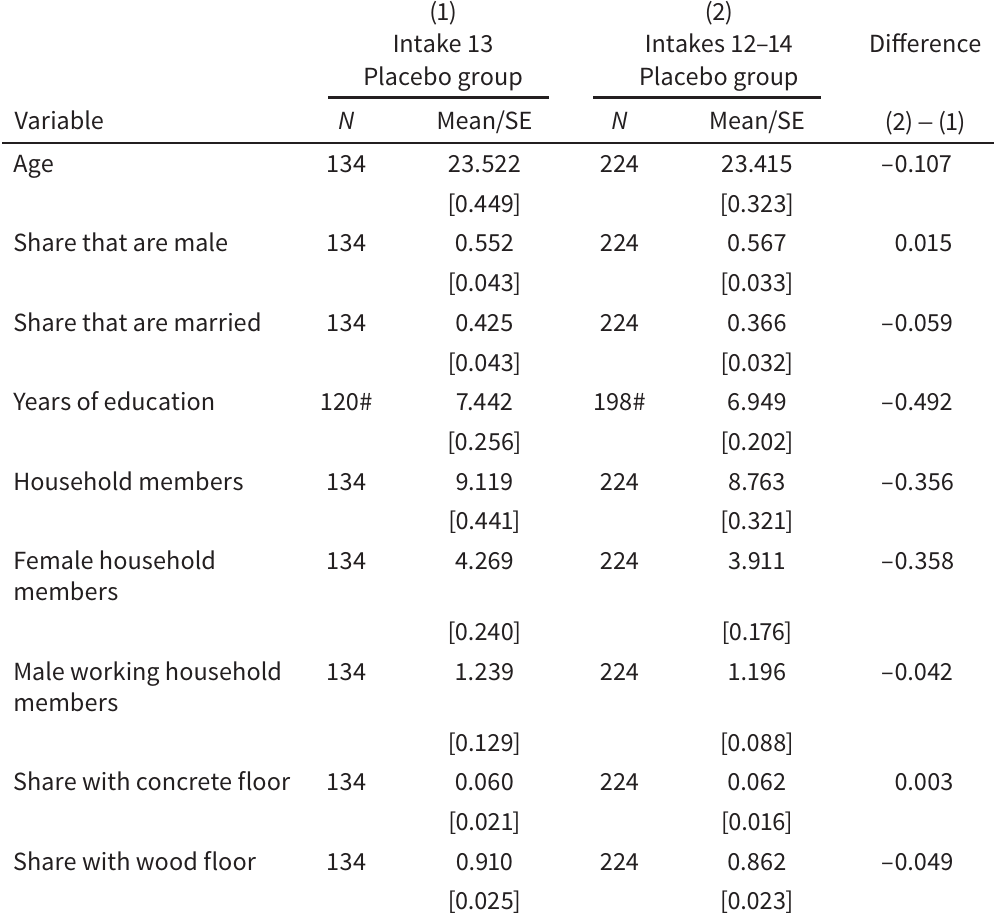
Statistical balance between placebo groups in intake 13 and intakes 12 and 14 (1) (2) Intake 13 Intakes 12–14 Difference Placebo group Placebo